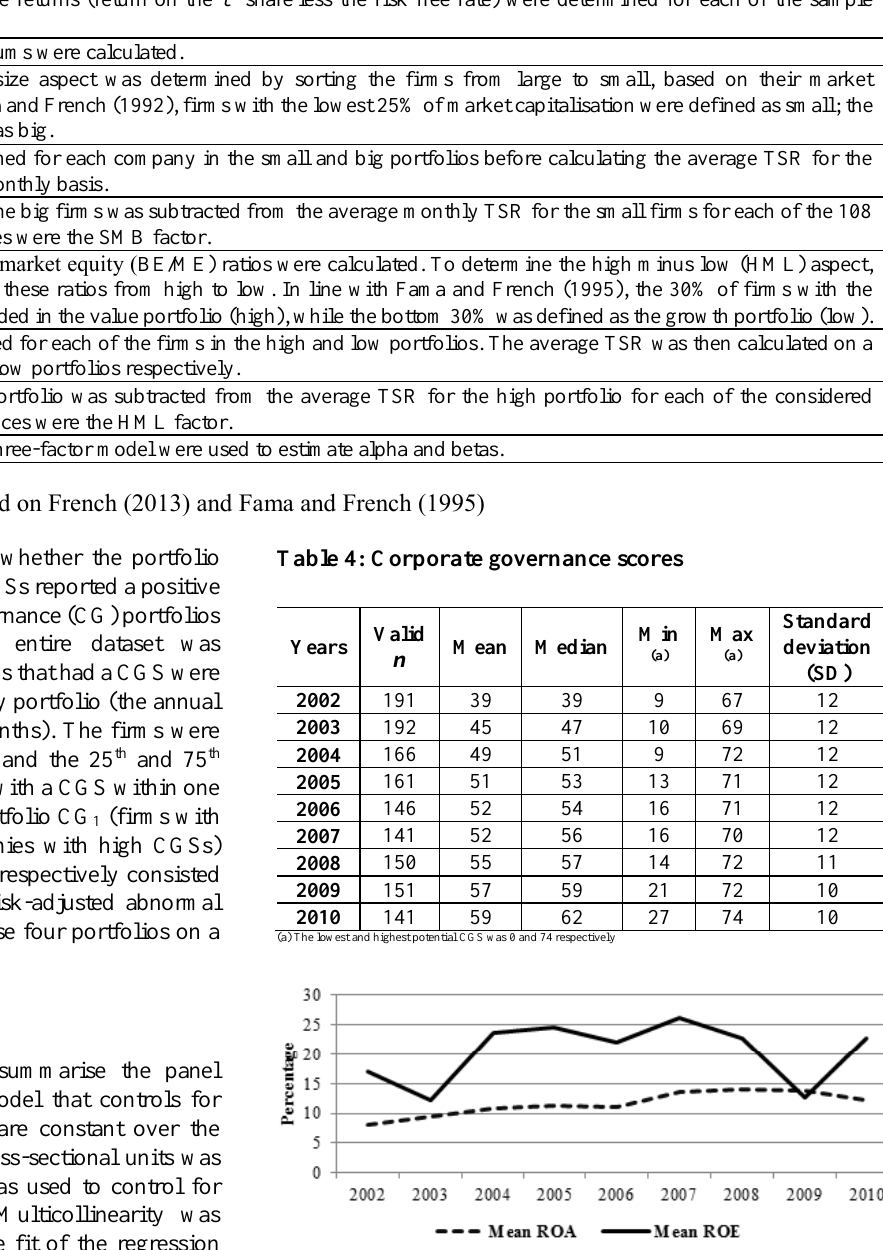
Table 3: Application of the CAPM and FAMA-French three-factor model